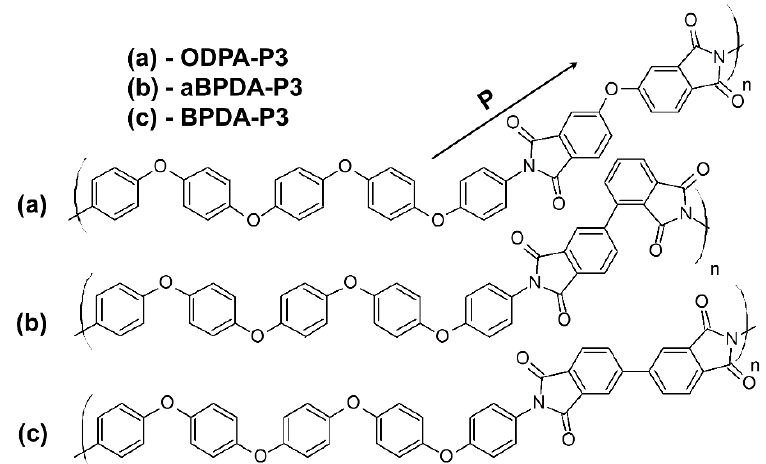
Figure 1. The chemical structure of the repeating units of the polyimides simulated in the present study: ODPA-P3 ( a ), aBPDA-P3 ( b ), and BPDA-P3 ( c ). The arrow marks vector P directed along the phthalimide planar moieties of the polyimide chains; its orientation relative to the nanotube axis was investigated. For clarity the vector P is shown only for the ODPA-P3 PI; for aBPDA-P3 and BPDA-P3 these vectors have been directed along the same fragments. Reproduced from [34] with permission, copyright Wiley, 2018.